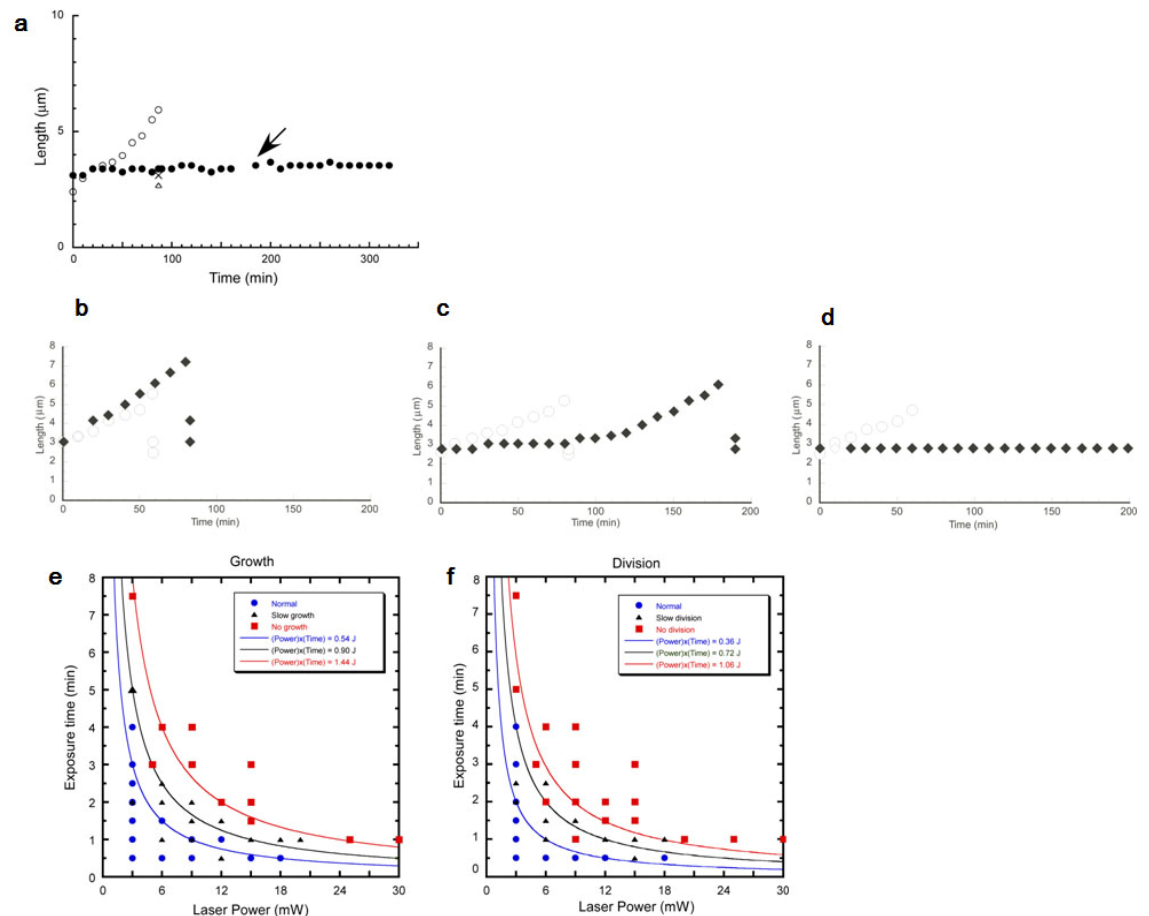
Figure 23. Damage to growth and division abilities at various laser power and trapping time conditions. ( a ) No growth and division in continuous trap. The graph shows time-course changes in lengths of both the continuously trapped daughter cell and the intact daughter cell. The length of trapped cell (filled circle points) showed almost no change in length in trapping (0–180 min) while the intact daughter cell grew and divided normally (open circle points). Though the trapped daughter cell was released from the trap at 180 min (black arrow), the length did not change for at least 140 min. even after the release. ( b – d ) Growth and division patterns of optically trapped cells under various trapping conditions. Three typical examples of growth and division patterns of trapped cells under various trapping conditions. (b) The trapped cell with no damage. It had almost the same growth speed and divided faster than the intact cell. (Laser power = 3 mW(Obj.), trapping time = 1 min). (c) The trapped cell with slower growth speed and longer interdivision time than the intact cell although it did grow and divide. (Laser power = 18 mW(Obj.), trapping time = 1 min). (d) The trapped cell with no growth and division. (Laser power = 15 mW(Obj.), trapping time = 2 min). ( e ) Damage estimated by their growth. ( f ) Damage estimated by their division. The blue circles in the graph represents the points of “normal”, the black triangles “slow”, and the red squares “no” growth,